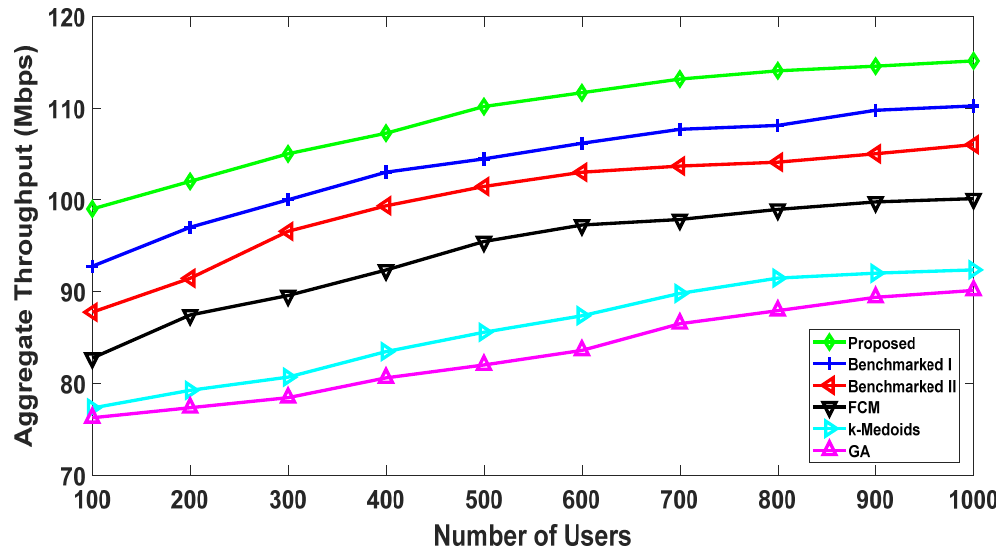
Figure 9. Aggregate throughput: comparison with the benchmarked ( 𝑤 (cid:2869) (cid:3404) 0.4, 𝑤 (cid:2870) (cid:3404) 0.6 ).